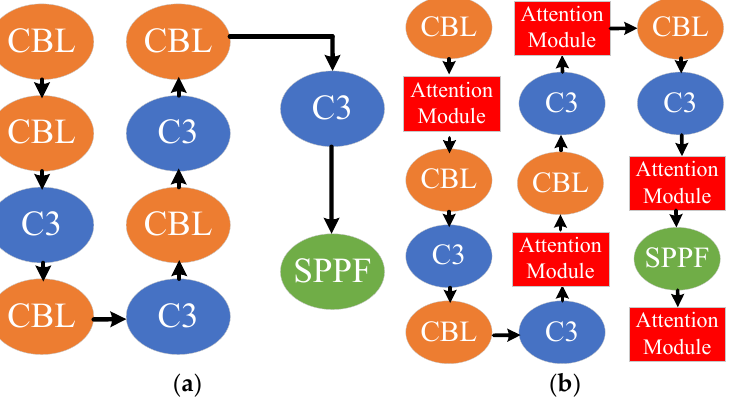
Figure 6. The architecture of backbone in YOLOV5: ( a ) the original backbone; ( b ) the improved